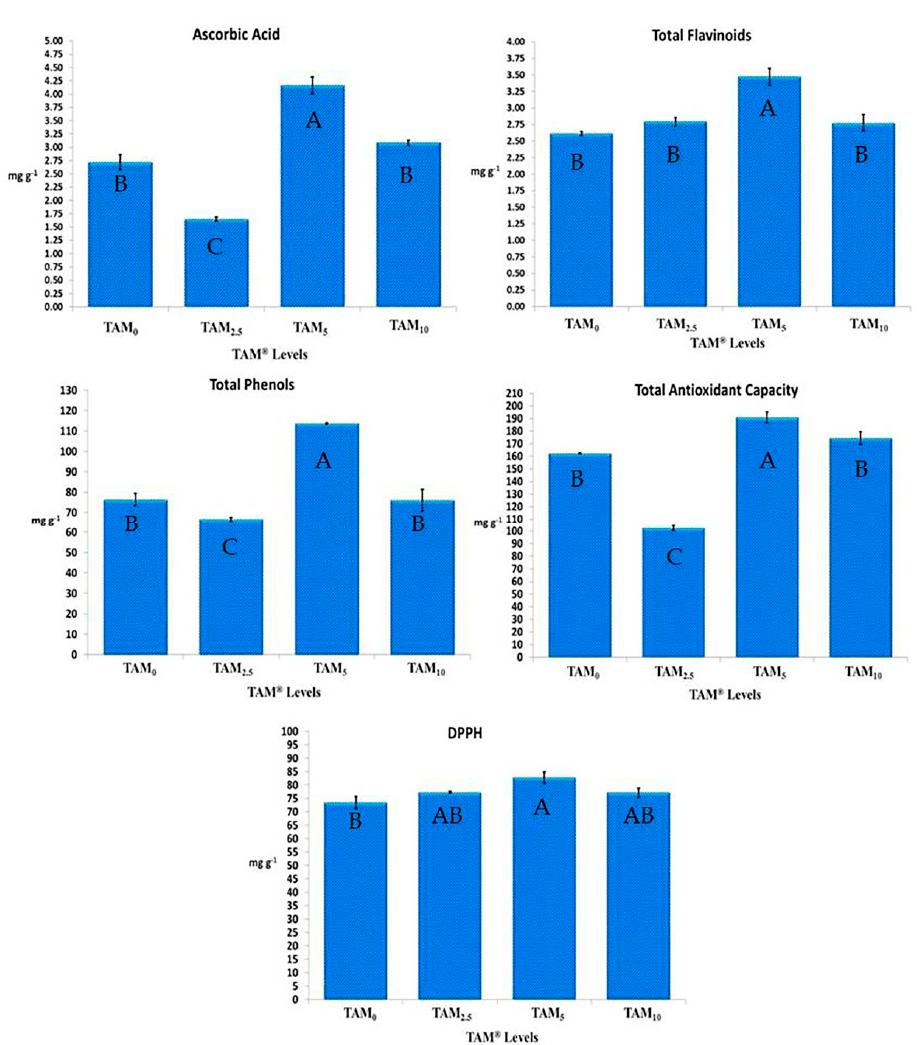
Figure 2. Antioxidant Activities of C. annuum treated with Crude TAM ® . Error bars indicate standard deviations of three replicates. Different superscript letters in each row indicate significant differences ( p < 0.05).